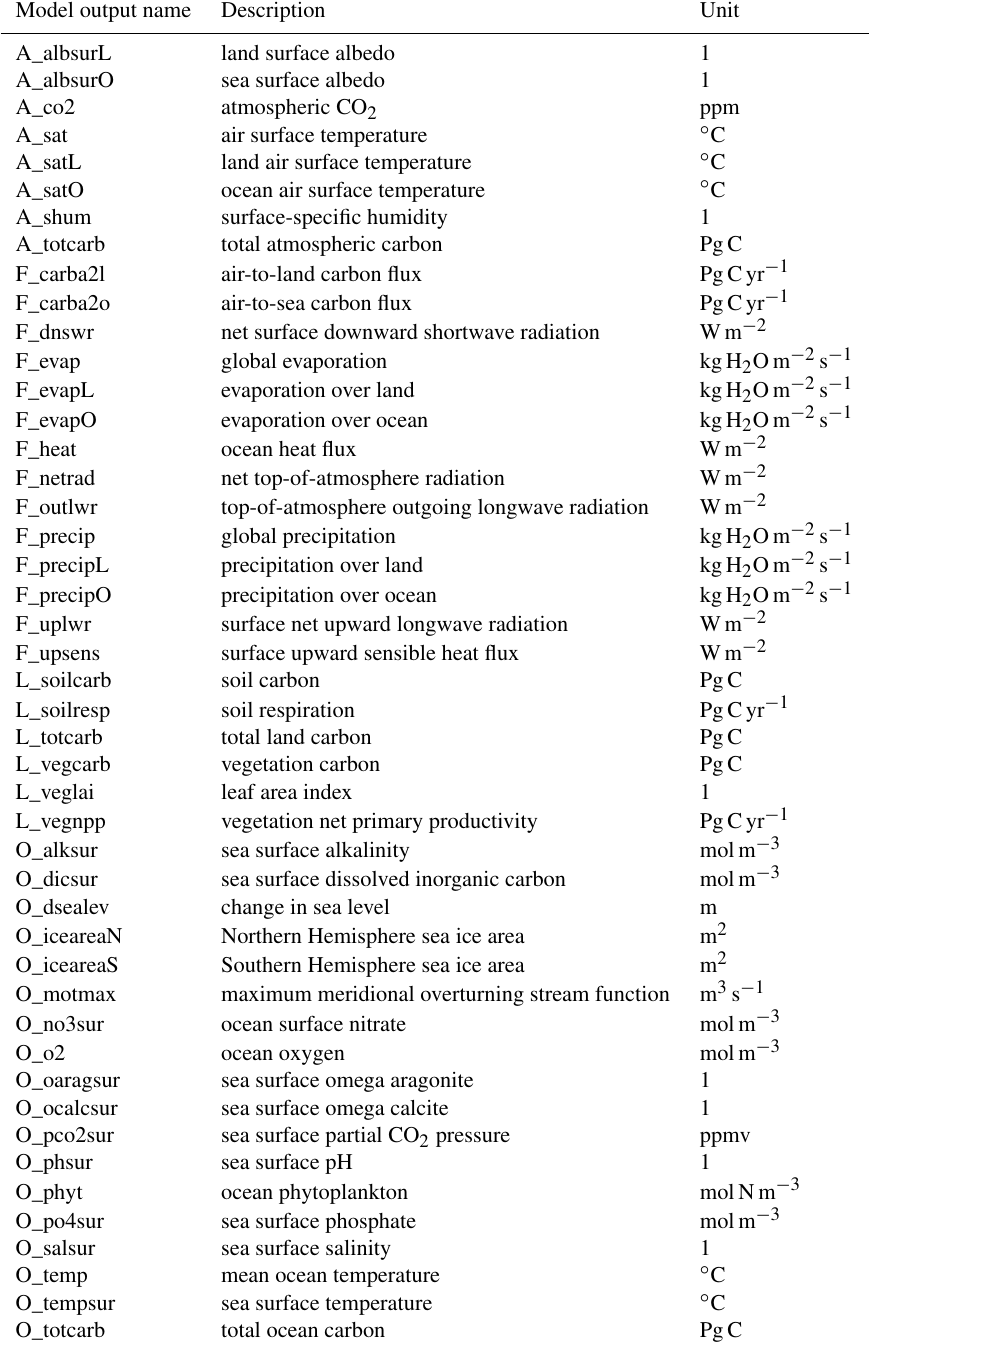
Table A1. List of globally aggregated model output variables considered in this